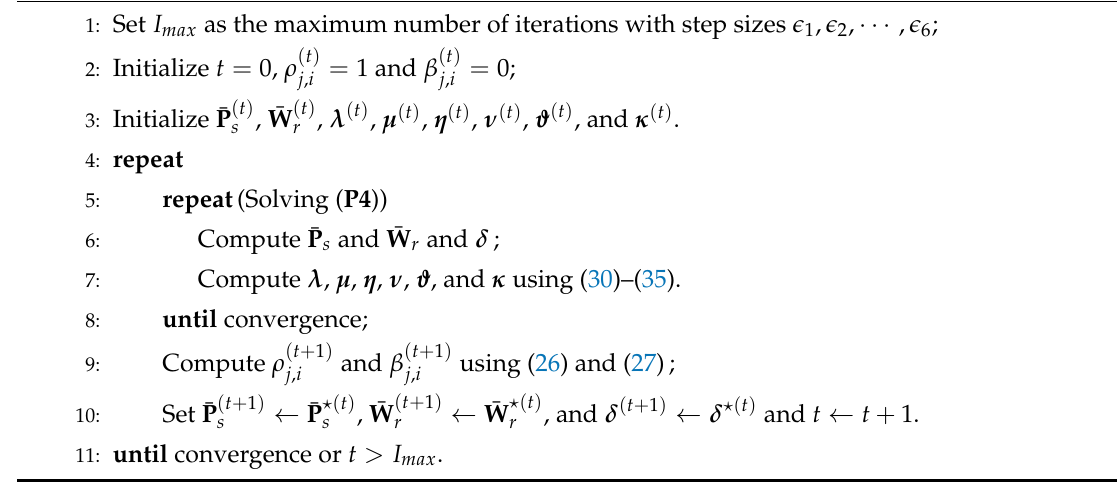
Algorithm 1: Proposed algorithm for given values of Ω s and Ω r